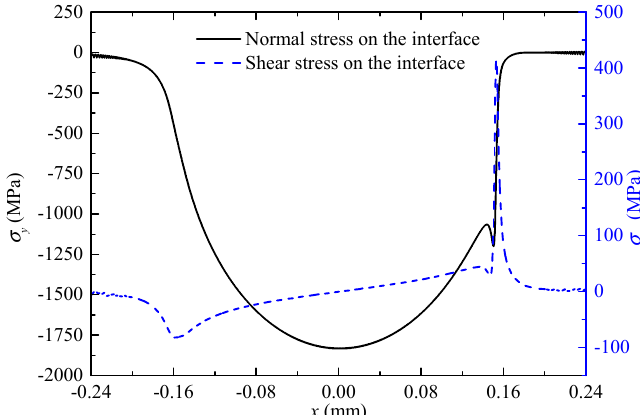
Normal stress on the interface Shear stress on the interface